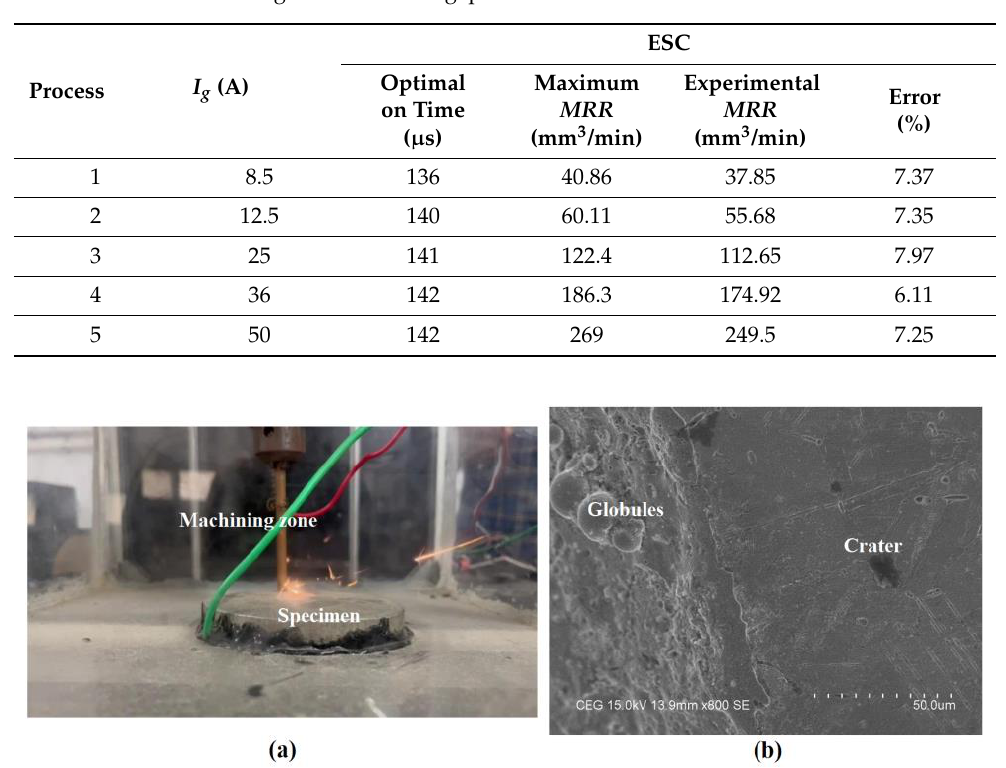
Figure 12. ( a ) EDM arrangement and ( b ) machine surface using